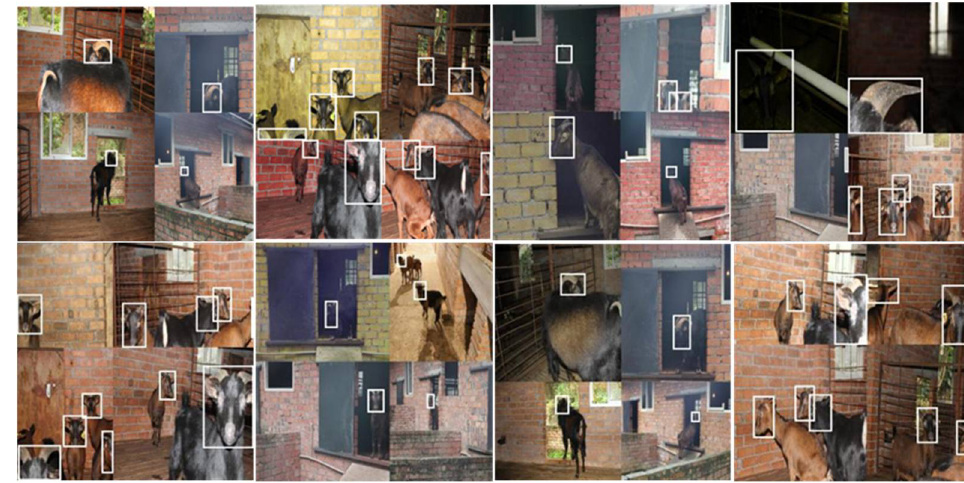
Figure 3. Images after Mosaic augmentation